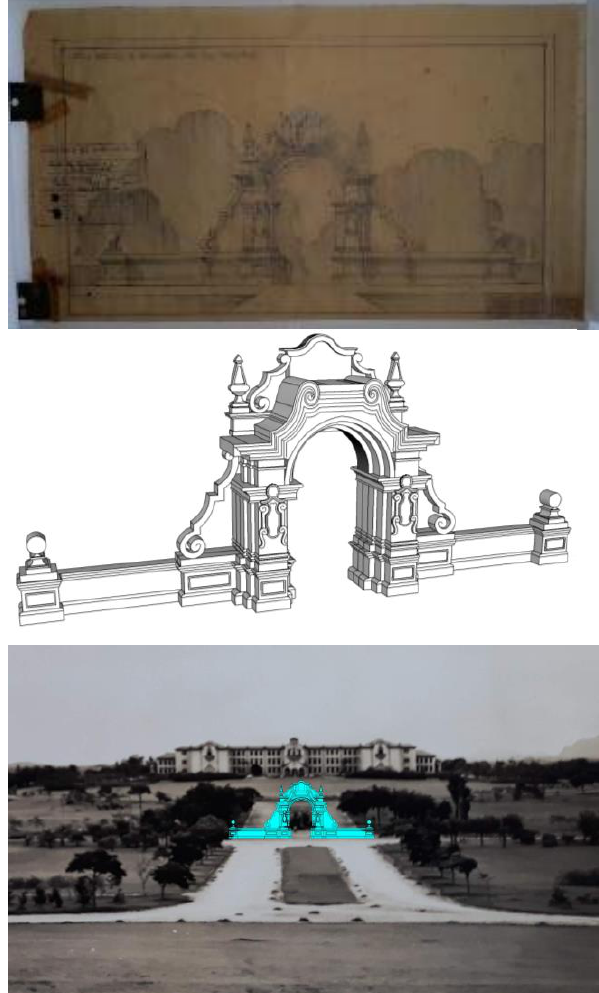
Figure 08 . Frontal elevation of the porch designed for campus